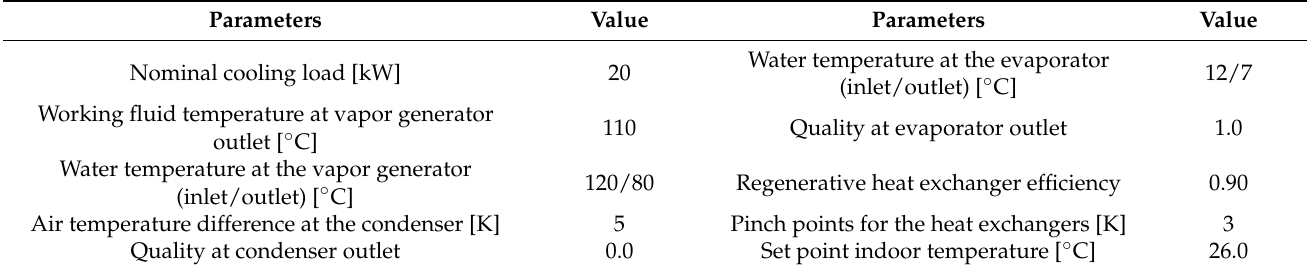
Table 1. Specification of the boundary conditions used for the sizing